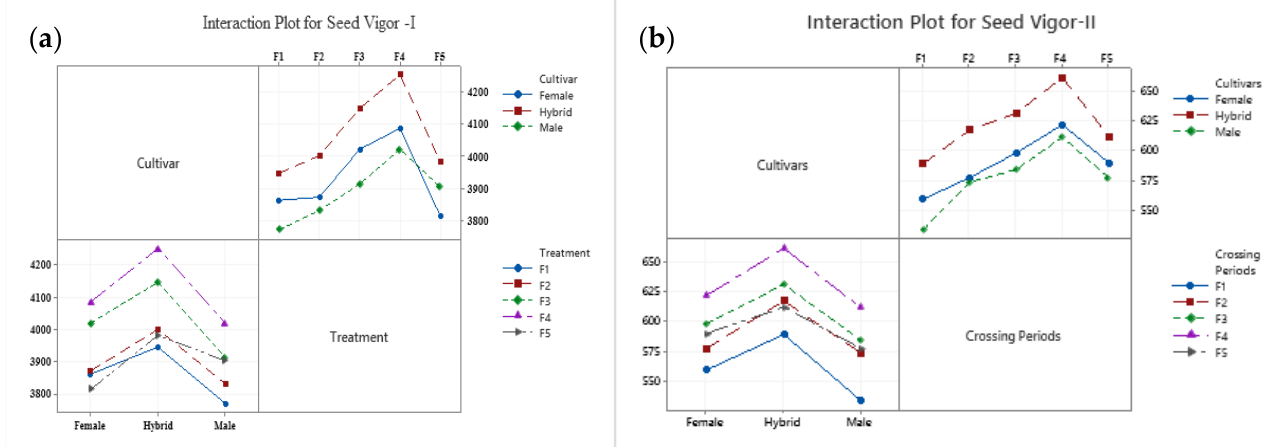
Figure 2. As an interaction plot, the seed vigor potential of bottle gourd hybrid HBGH-35 and two parental lines, female Pusa Naveen and male G2-line, were plotted. ( a ) Seed vigor I and ( b ) seed vigor II.